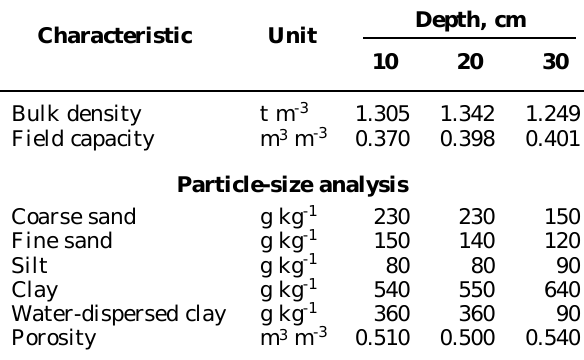
& white photographs of polished blocks were taken in a dark room, using a U.V. lamp (Altemuller & van Vliet-Lanoe,